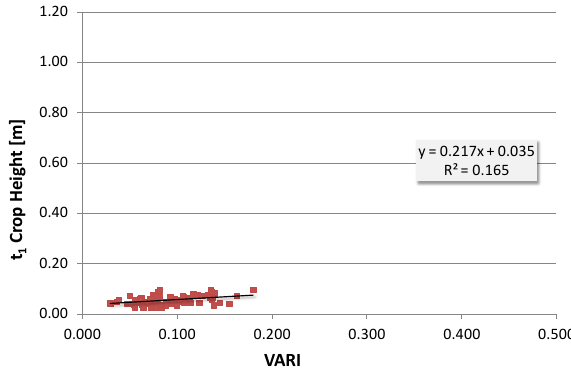
Figure 10. Correlation between vegetation index VARI and crop height for winter wheat trial, measured 3. May 2013 Crop growth in the second period (end of May) was in full swing and the plant height could be determined reliably. The plant vigor, which can be represented on the VARI vegetation index is closely correlated with the size and growth of the crop. This is not surprising, because vital plants are often greater than less vital, diseased plants, see figure. 11.